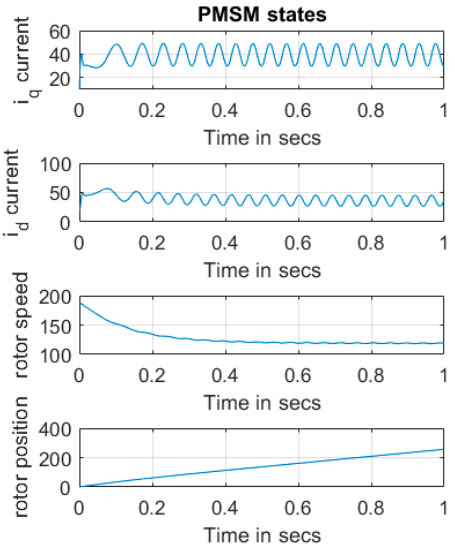
Figure 3. Variation of the PMSM-driven propeller non-dimensional coefficients of thrust and torque, propulsive efficiency, and advance ratio as a function of time over the timeframe of 1 s at normal room temperature. Aerospace 2017 , 4 , x FOR PEER REVIEW